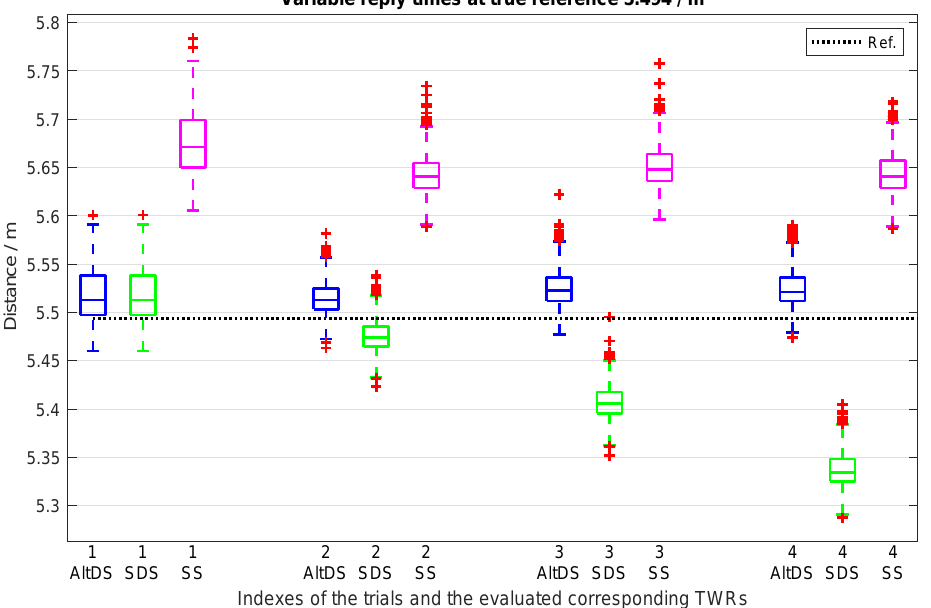
Figure 13. Variable reply times at fixed distance measurement.